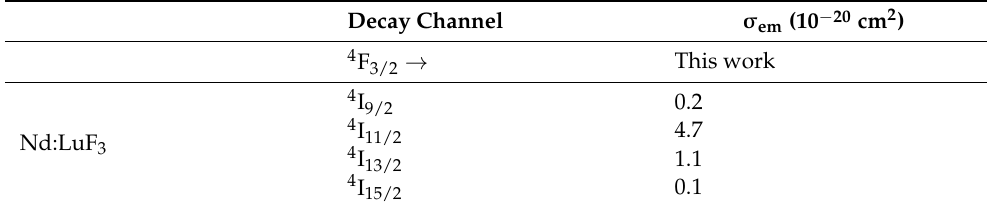
Table 6. Emission cross-sections of Nd:LuF 3